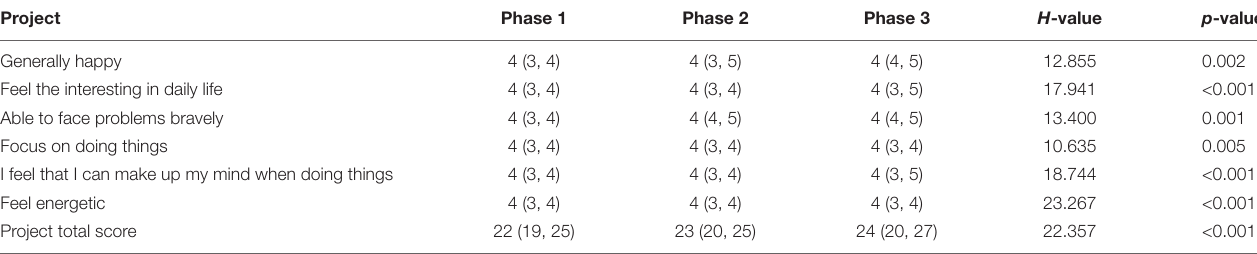
TABLE 3 | Score of college students’ negative mental state scale and Kruskal–Wallis H test in the three stages of the pandemic [Points, M (P25, P75)]. Project